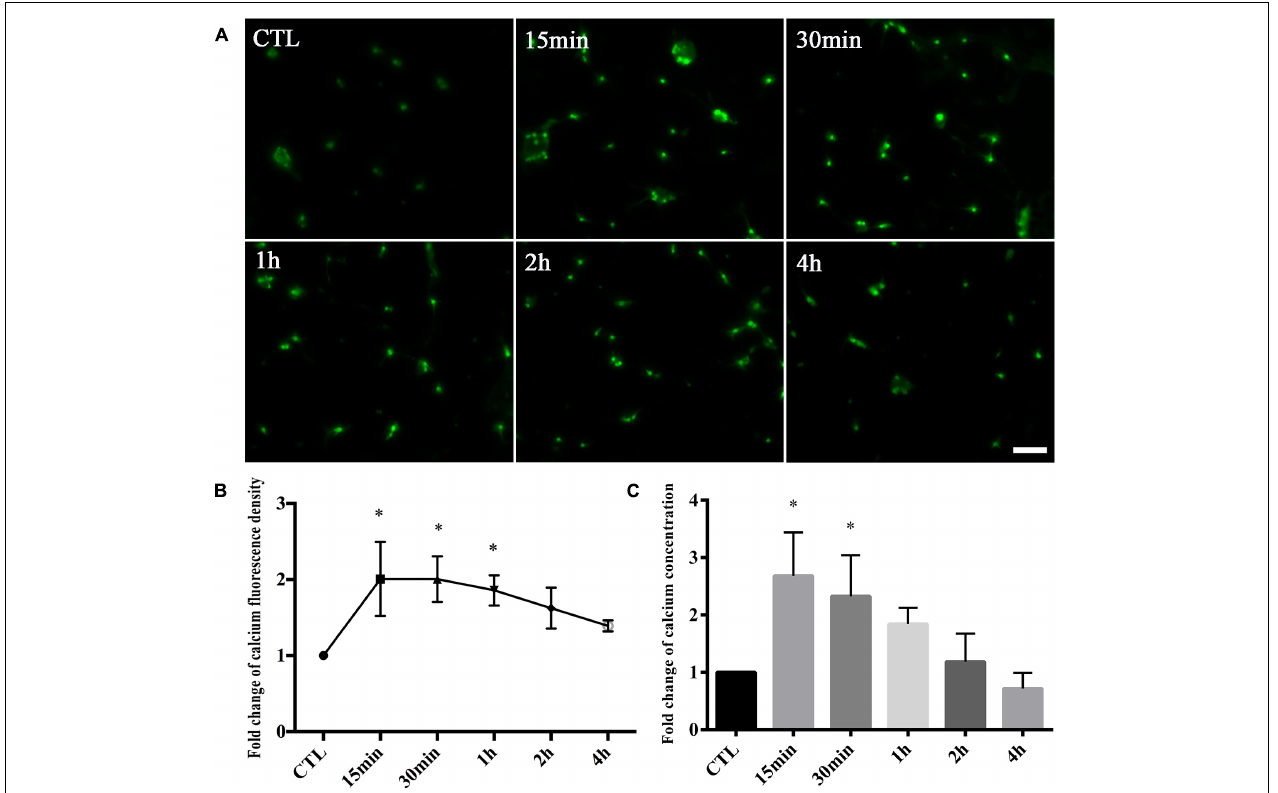
FIGURE 1 | Calcium concentrations in retinal neuron cultures treated with 50 µ M glutamate injury for different time points. (A) Calcium concentrations indicated by Fluo-4 signals. (B) Quantitative analysis of Fluo-4 fluorescence signal intensity. (C) The fold change of calcium concentrations was determined by cell calcium assay kit. Data were analyzed using one-way ANOVA. ∗ p < 0.05 vs. CTL group. These data are representative of results from five independent experiments. Scale bar = 20 µ m in all